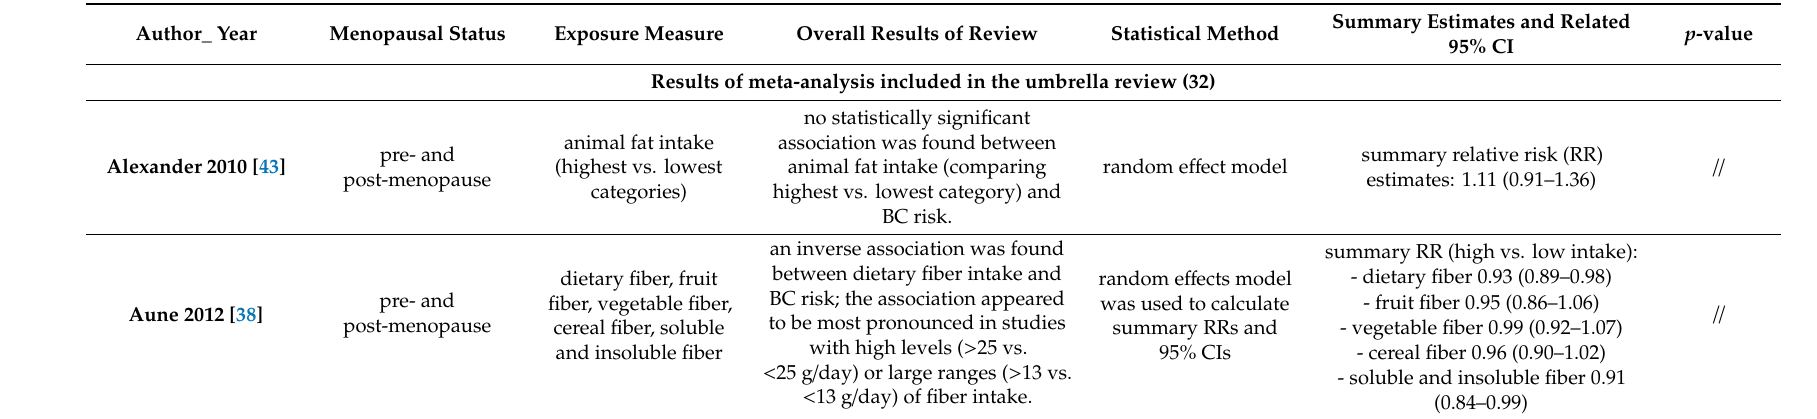
Table 2. Results of studies included in the umbrella